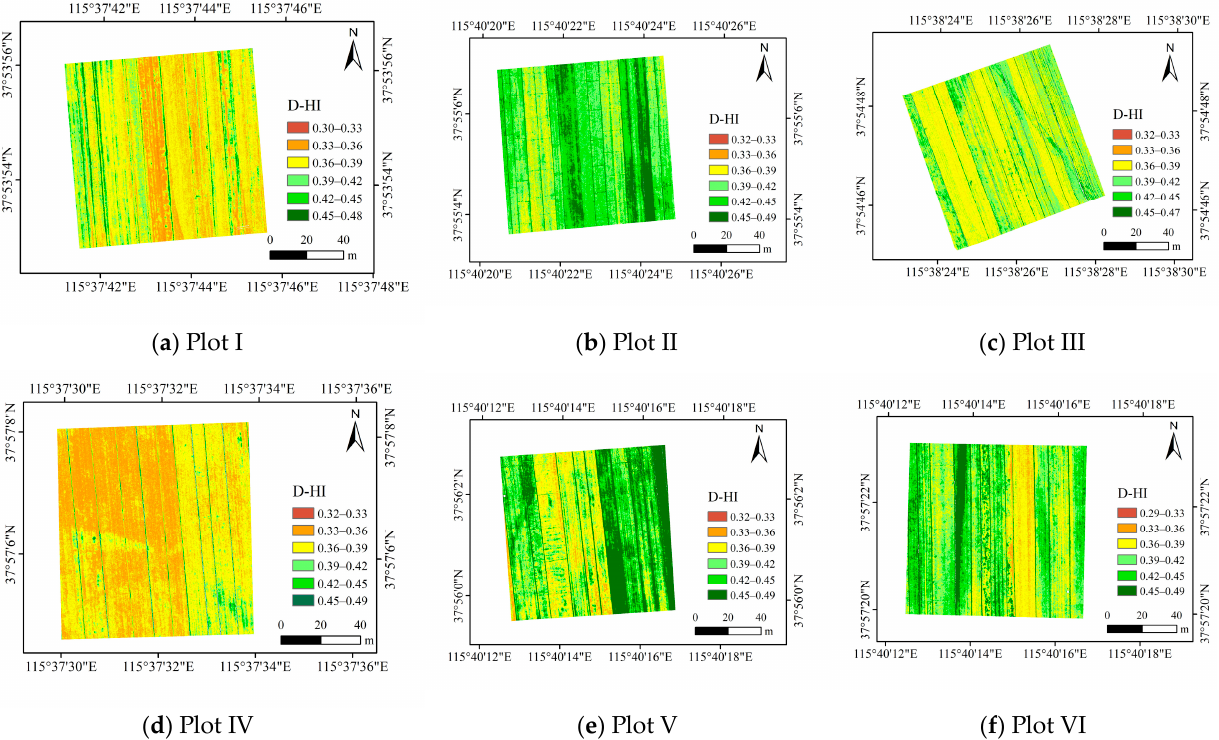
Figure 13. D-HI estimation results based on the sensitive band centers λ (724 nm, 784 nm) (25 May 2021).